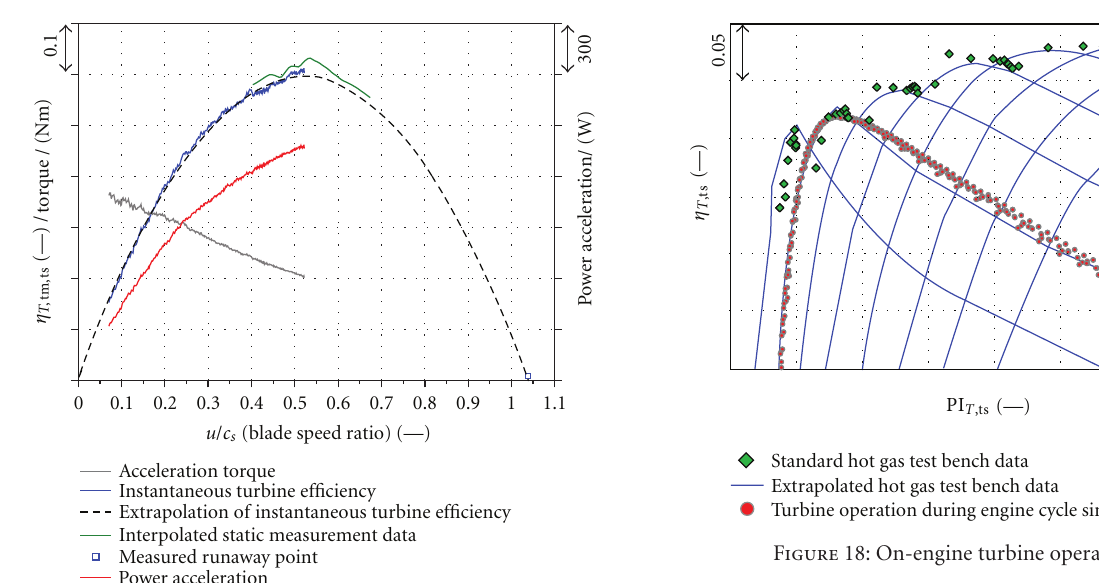
Figure 17: Comparison of steady and unsteady test results.